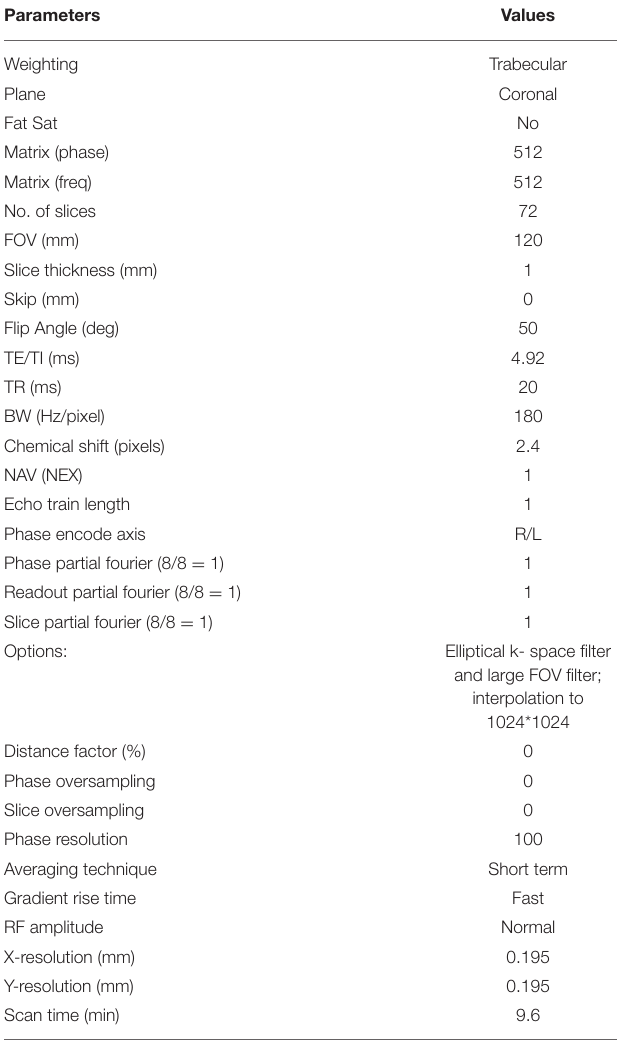
TABLE 1 | MRI protocol details of 3D FISP (from OAI instruction documents \ operations manuals \ MRI manuals). Parameters